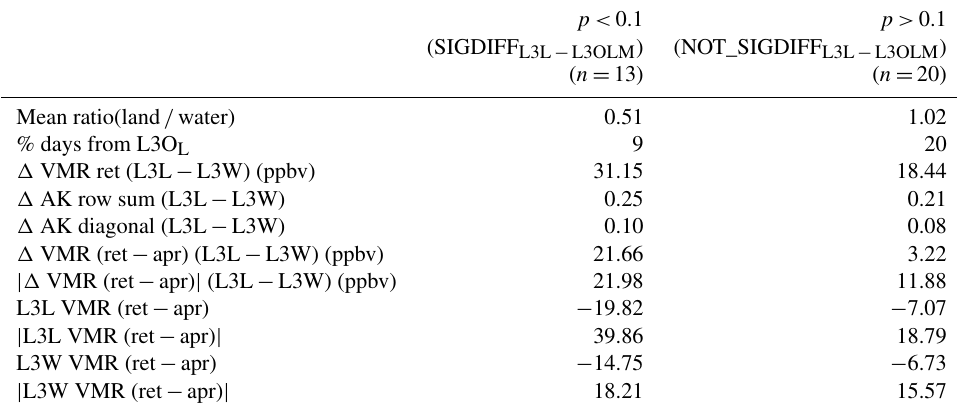
Table 8. Selected parameters from L3 grid boxes containing cities, stratified according to whether the mean VMR in L3L and L3O LM is significantly different (SIGDIFF L3L − L3OLM ; p < 0.1) or not (NOT_SIGDIFF L3L − L3OLM